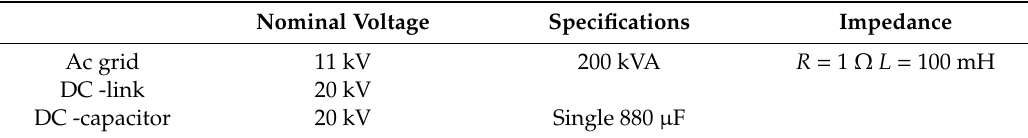
Table 1. VSC specifications for SST.